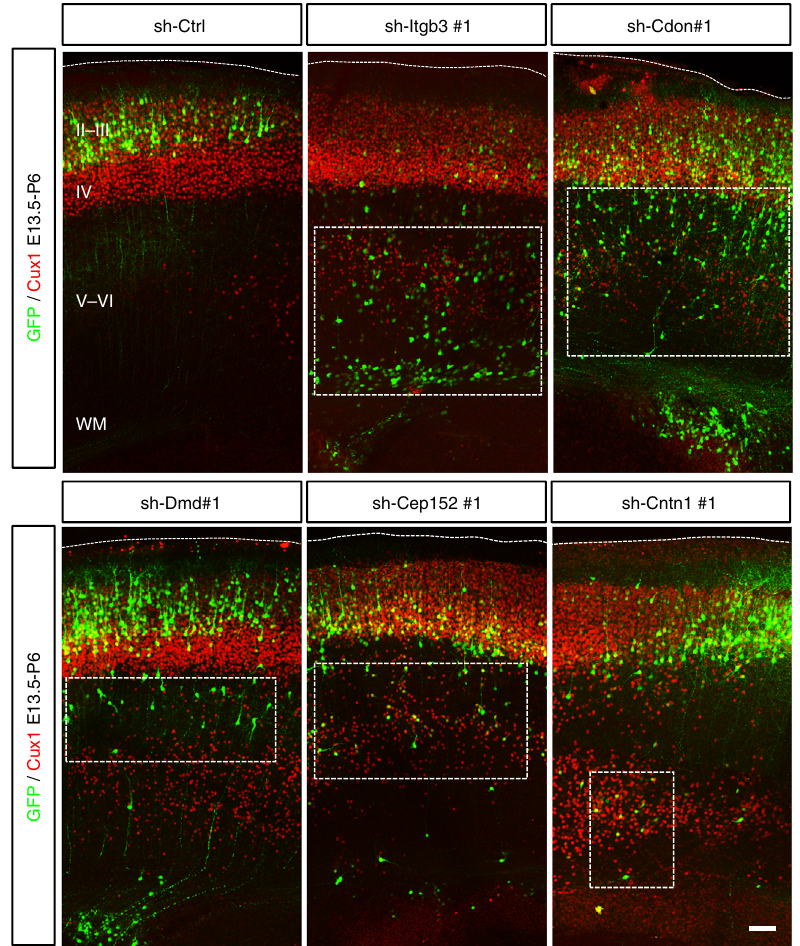
Fig. 6 Ectopic neurons of P6 brains electroporated with shRNAs targeting MCD candidate genes. Brains were electroporated with shRNAs at E14.5 and fi xed at P6. Marker of layer 2 – 4 cells, Cux1 (red), were used for cell identities. In control brains, neurons have reached layers 2/3 and 4 of the cortex by P6. However, brains electroporated with shRNAs targeting Itgb3 , Cdon , Dmd , Cep152 , and Cntn1 along with GFP (green) exhibited different numbers of ectopic neurons underneath layer 4 online protocols (Supplementary Table 7). The human full-length cDNA for rescue experiments were purchased from the Mammalian Gene Collection (MGC) pre- mier clone (TransOMIC technologies).